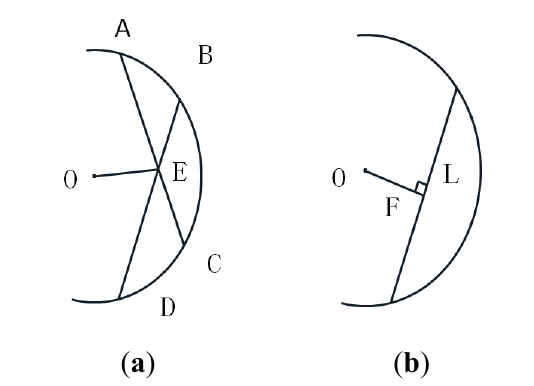
Figure 9. Geometrical features of a circle. ( a ) constraint condition1; ( b ) constraint